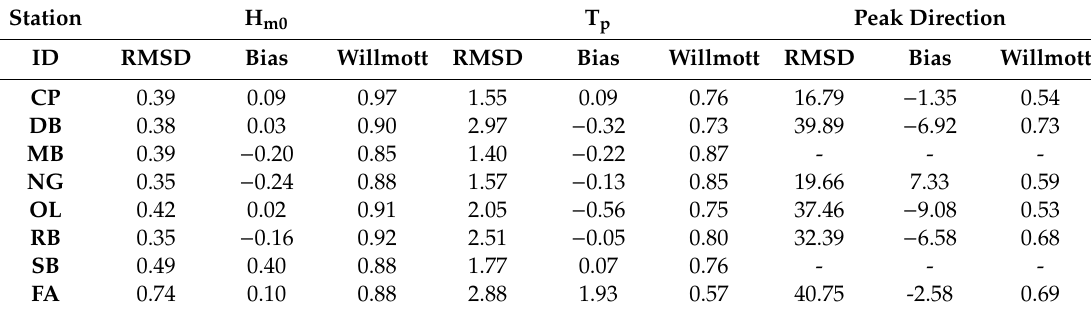
Table A1. Model performance statistics per coastal buoy location for JJA 2017, M1.